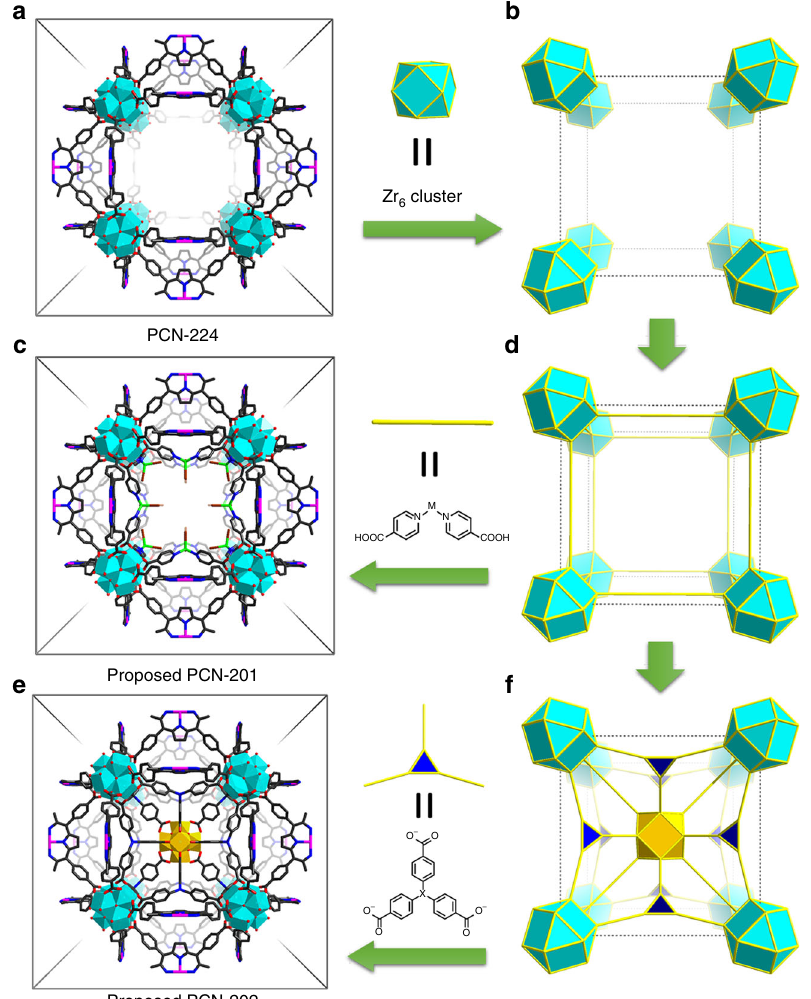
Fig. 2 Design of multi-component MOFs based on PCN-224 prototype. a The unit cell of PCN-224 and b the cubic cage con fi ned by eight clusters. c The unit cell of proposed structure PCN-201 and d the topological representation of PCN-201 with linear metal-INA fragments incorporated. e The unit cell of proposed structure PCN-202 and f the topological representation of PCN-202 with a tritopic linker and 12-connected cluster